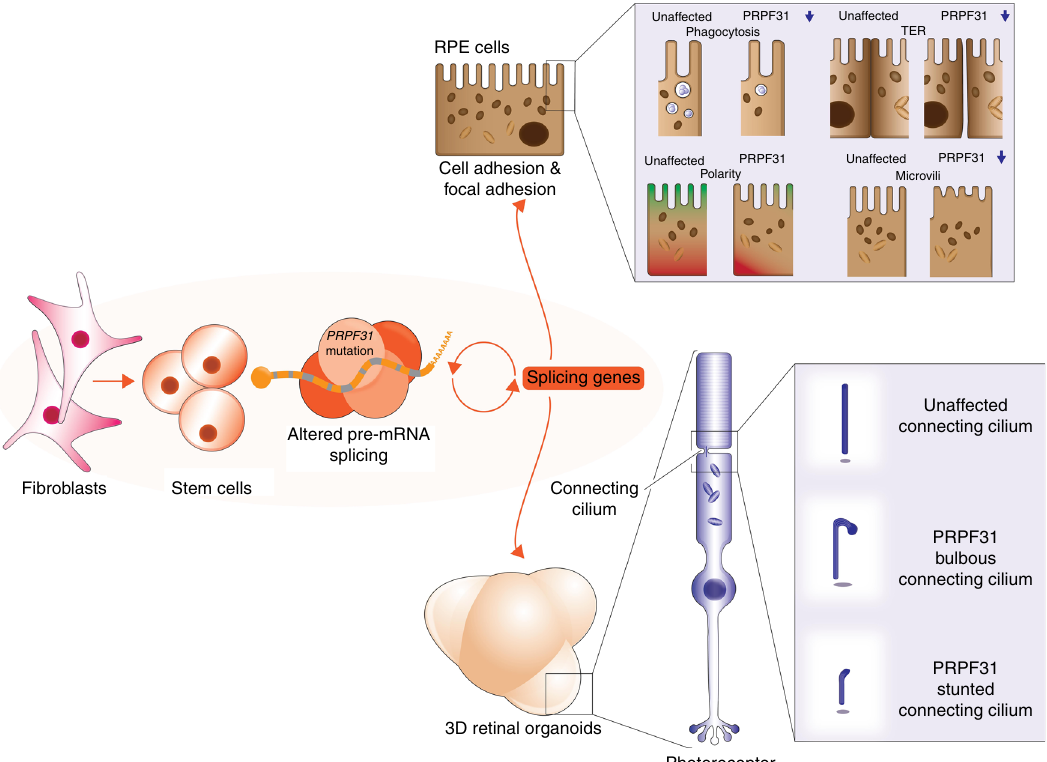
Fig. 8 Schematic diagram that summarises pathogenic pathways in the RP11 disease state. Altered pre-mRNA splicing in iPSC-derived RPE and retinal organoids is associated with severe RPE defects and disrupted cilia in